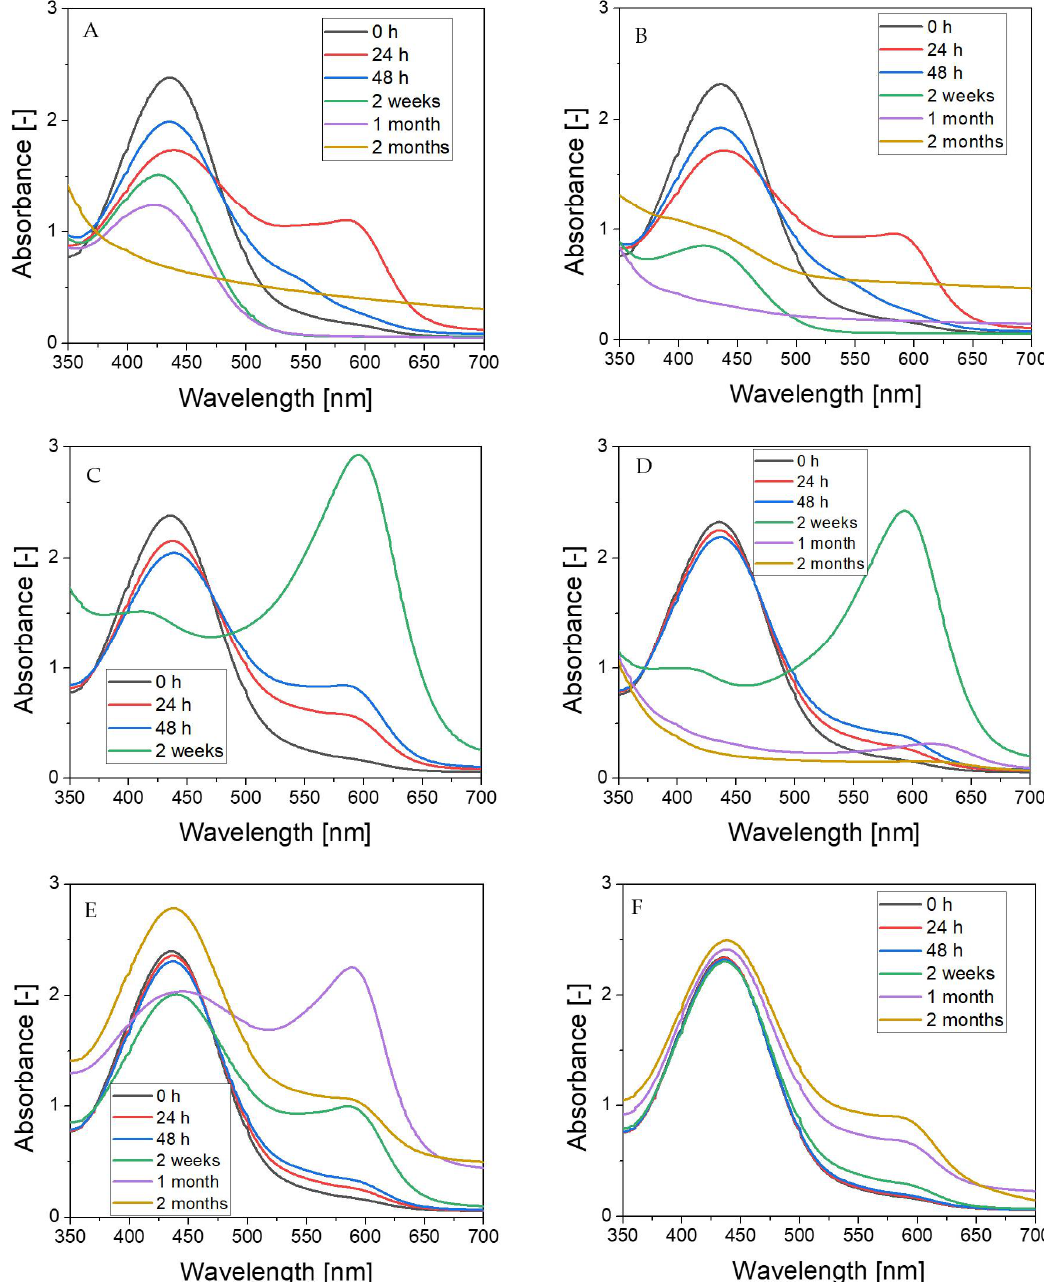
Figure 6. Absorbance spectra of the Fricke-XO-Pluronic F-127 dosimeter without and with 0.2 M NaCl stored under different conditions: ( A )—with NaCl, stored at room temperature, and exposed to light; ( B )—without NaCl, stored at room temperature, and exposed to light; ( C )—with NaCl, stored at room temperature, protected from light; ( D )—without NaCl, stored at room temperature, protected from light; ( E )—with NaCl, stored at about 4 °C in a refrigerator, and protected from light; and ( F )—without NaCl, stored at about 4 °C in a refrigerator, and protected from light.